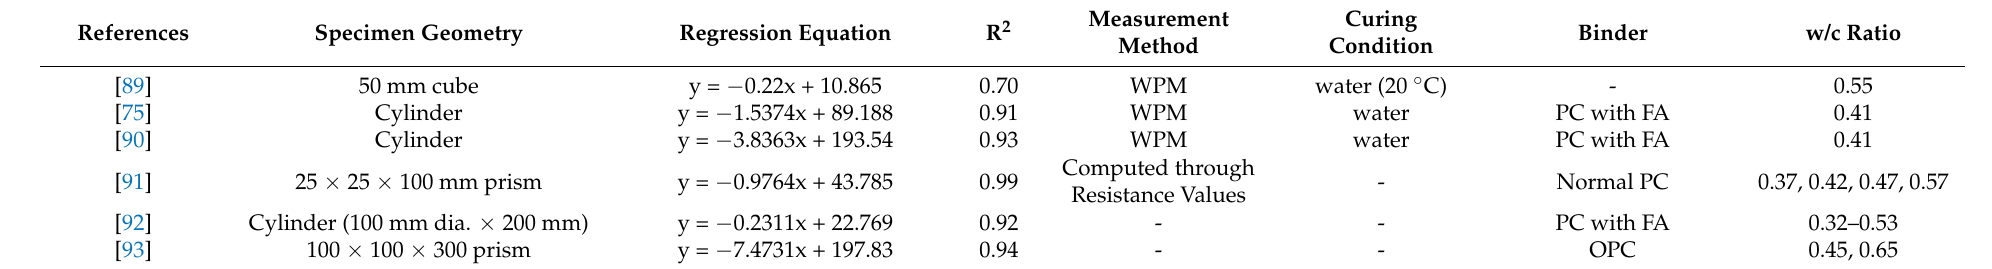
Table 3. Details of Specimens used from different references for the effect of temperature on electrical resistivity, including the specimen geometry, regression equation, measurement method, curing condition, age, type of binder, and w/c